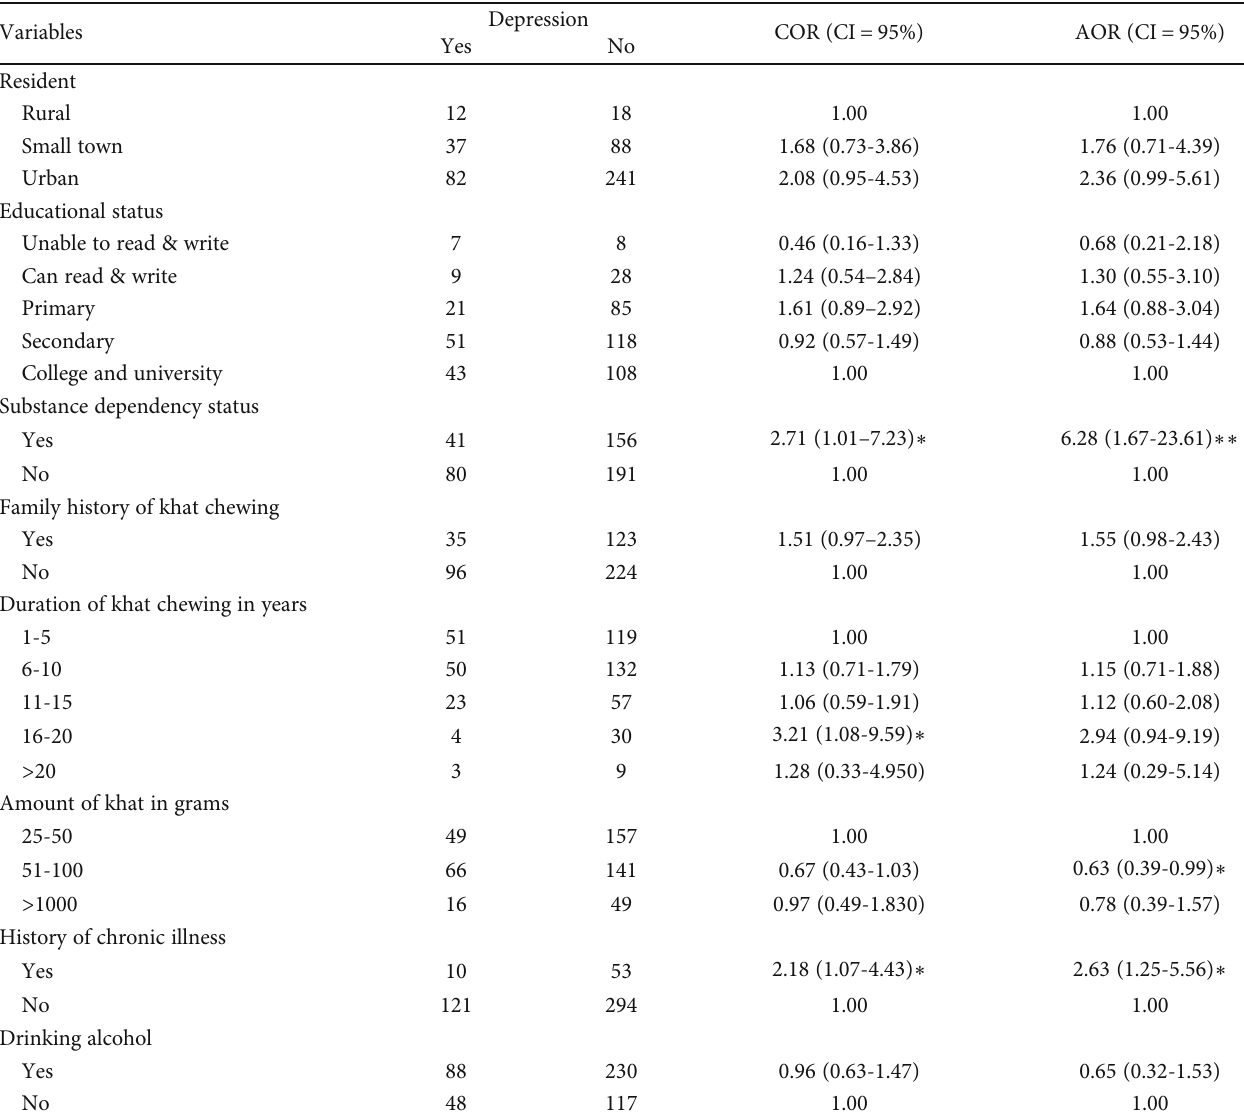
Table 6: Bivariate and multivariate logistic regression factors associated with depression among chronic khat chewers in the Amhara region,